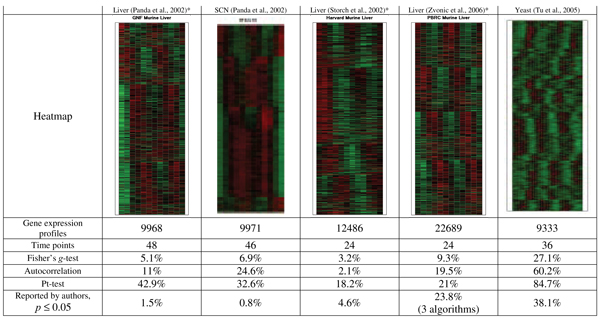
Analysis of circadian periodicity in tree murine liver data sets by thee algorithms. The heatmaps present all genes in each data set grouped by phase shift and sorted by Pt-test p-value, similar to Figure 2. The last row shows the fraction of oscillating genes as reported in the original publications and supplementary materials. Data from columns marked * has been previously published in [4]